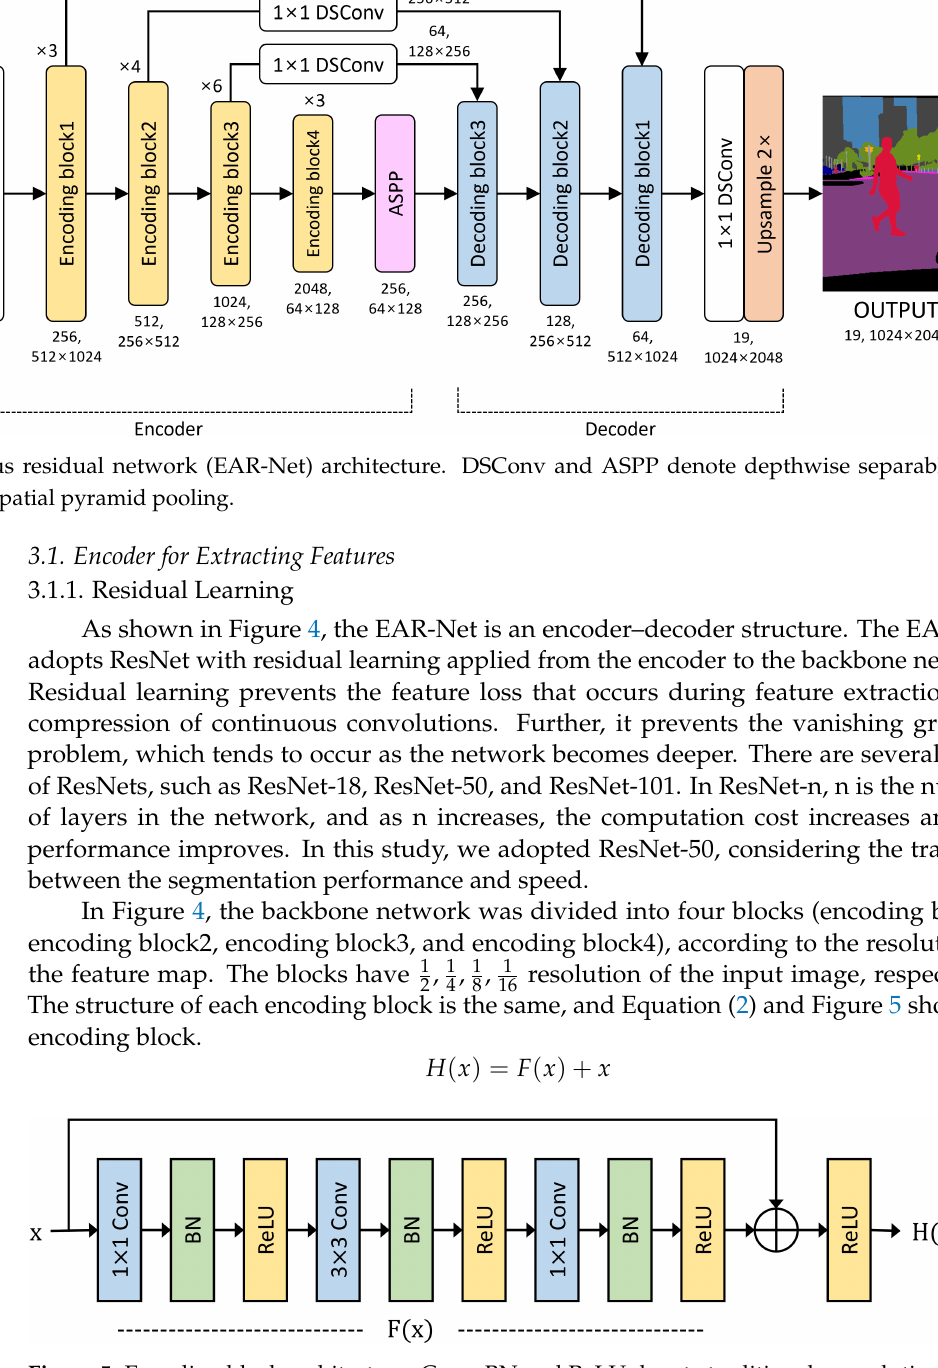
Figure 5. Encoding block architecture. Conv, BN and ReLU denote traditional convolution, batch normalization and rectified linear